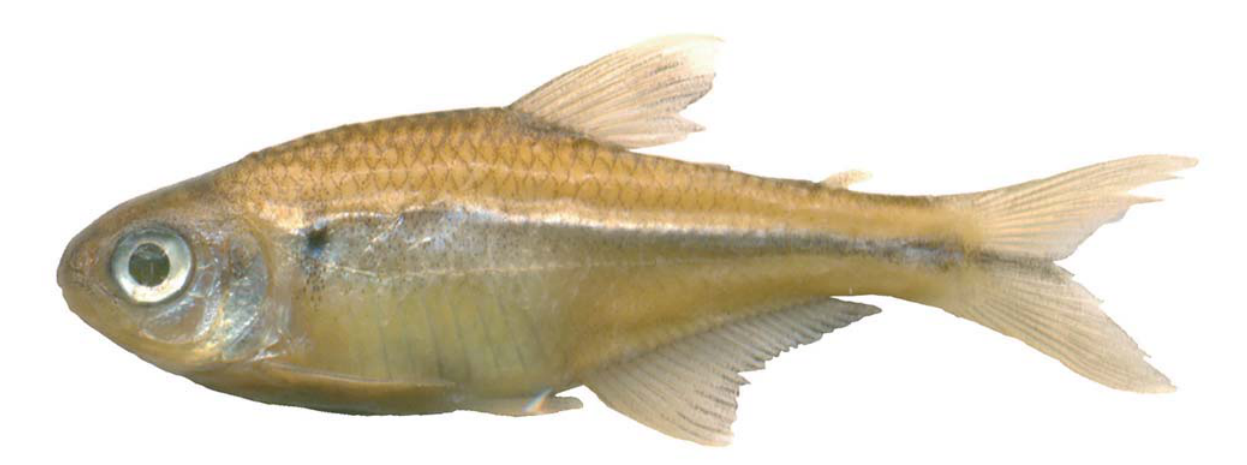
Fig. 1. Knodus shinahota , holotype, LIRP 5722, 33.7 mm SL (male): Bolivia, río Shinahota, río Chapare basin, rio Mamoré system. Photo by Alexandre C.